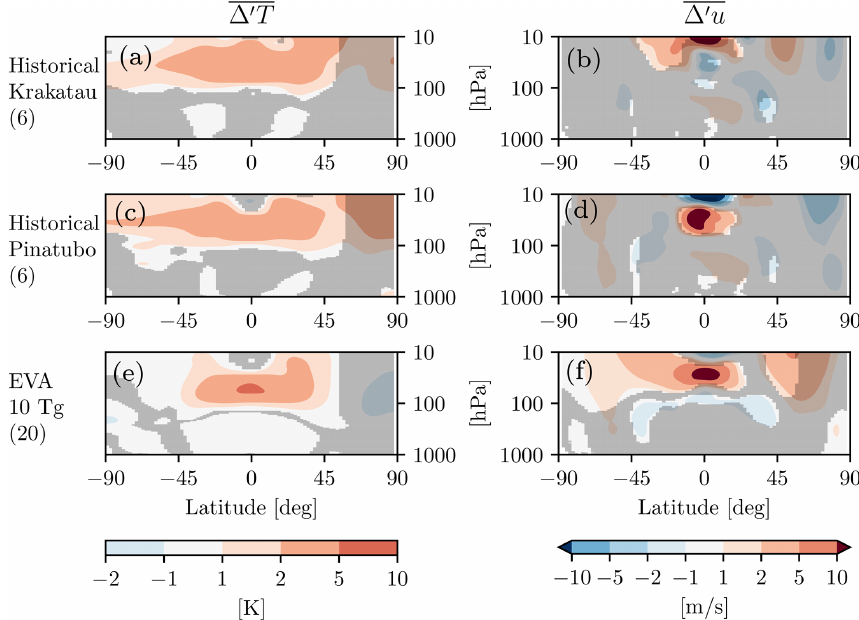
Figure A2. As in Fig. 2, but using the difference-from-reference-period method, for Krakatau (a, b) , Pinatubo (c, d) , and EVA aerosols at 10Tg(S) (e, f) , with the ensemble size in parentheses in (a) , (c) , and (e) .